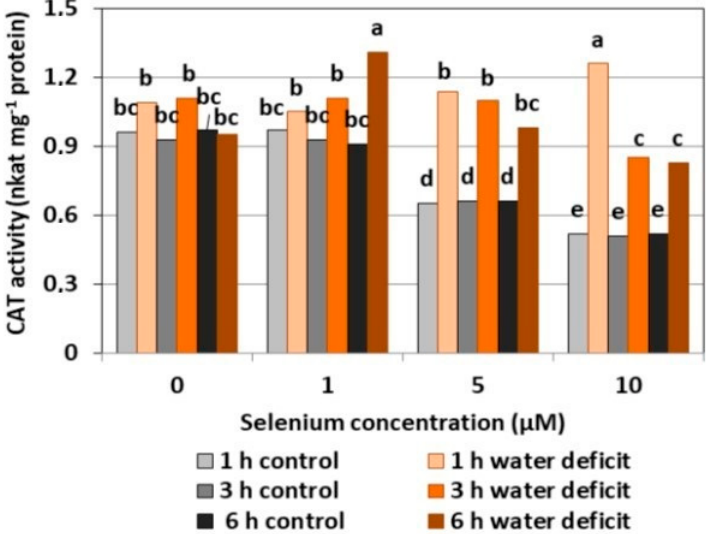
Figure 6. The catalase (CAT) activity in the roots of cucumber seedlings pre-treated with Se and subjected to a WD. Bars marked with the same letters do not differ significantly at p < 0.05.